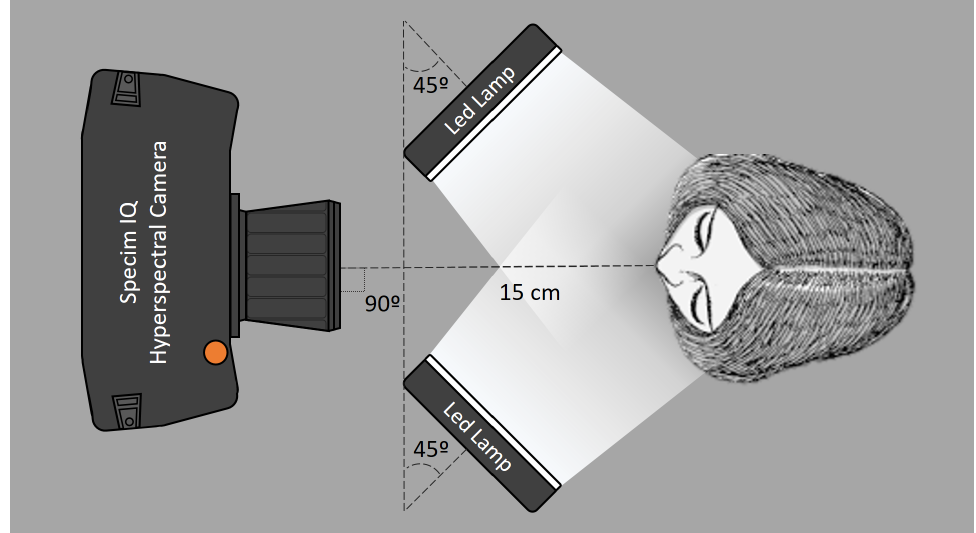
Figure 1. Schematic representation of the measurement set-up used to measure the hyperspectral reflectance images of the four maxillary